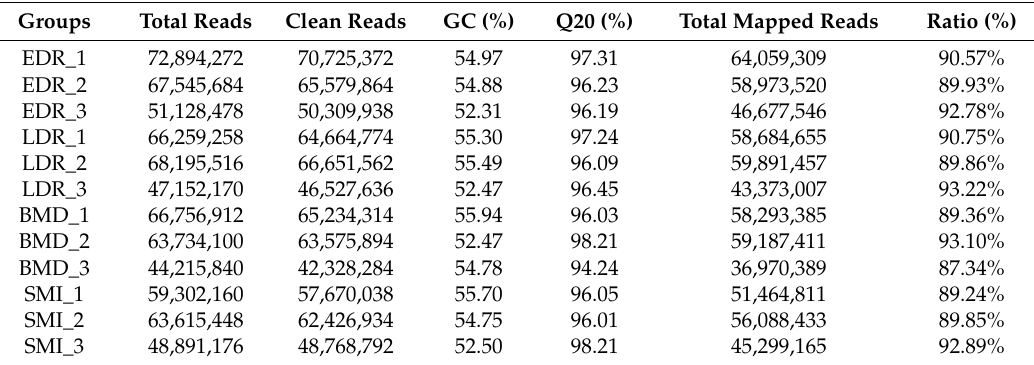
Table 1. Summary of transcriptome sequencing